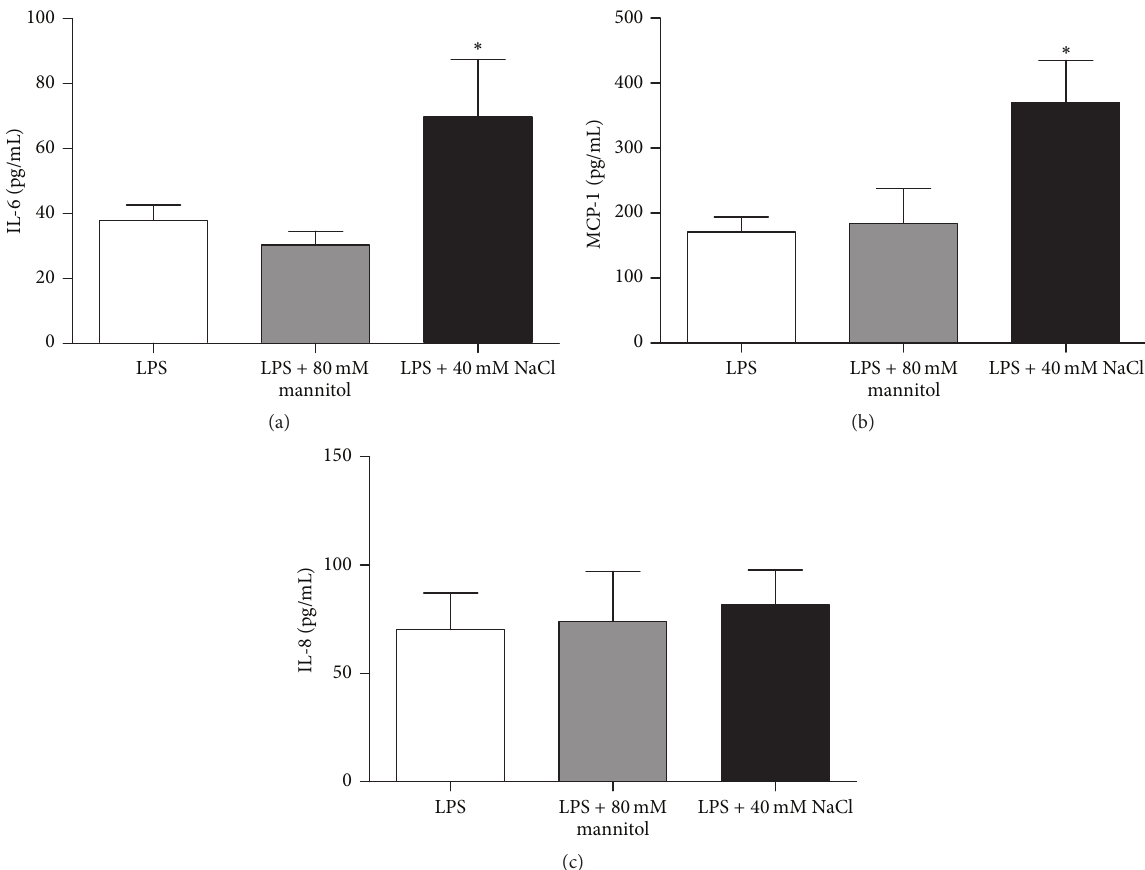
Figure3:OsmoticstressbyitselfhadnoeffectonthesecretionofcytokinesbyARPE-19cells.Cellswerepreculturedwithserum-freemedium for 24 h and then stimulated by LPS and cultured with medium alone, medium containing 80 mM mannitol, or medium with extra 40mM NaCl for 24h. The secretion of IL-6 (a), MCP-1 (b), and IL-8 (c) was measured by ELISA. The data are expressed as means ± SD of three independent experiments. ∗ 𝑃 < 0.05 compared to the value of control, 𝑛 = 8 . Paired-samples t -test (when the difference between the two tested groups conforms to normal distribution) or Wilcoxon matched-pairs test (when the difference between the two tested groups does not conform to normal distribution) was used for statistical analyses for LPS control versus LPS + 80 mM mannitol or LPS + 40 mM NaCl in each